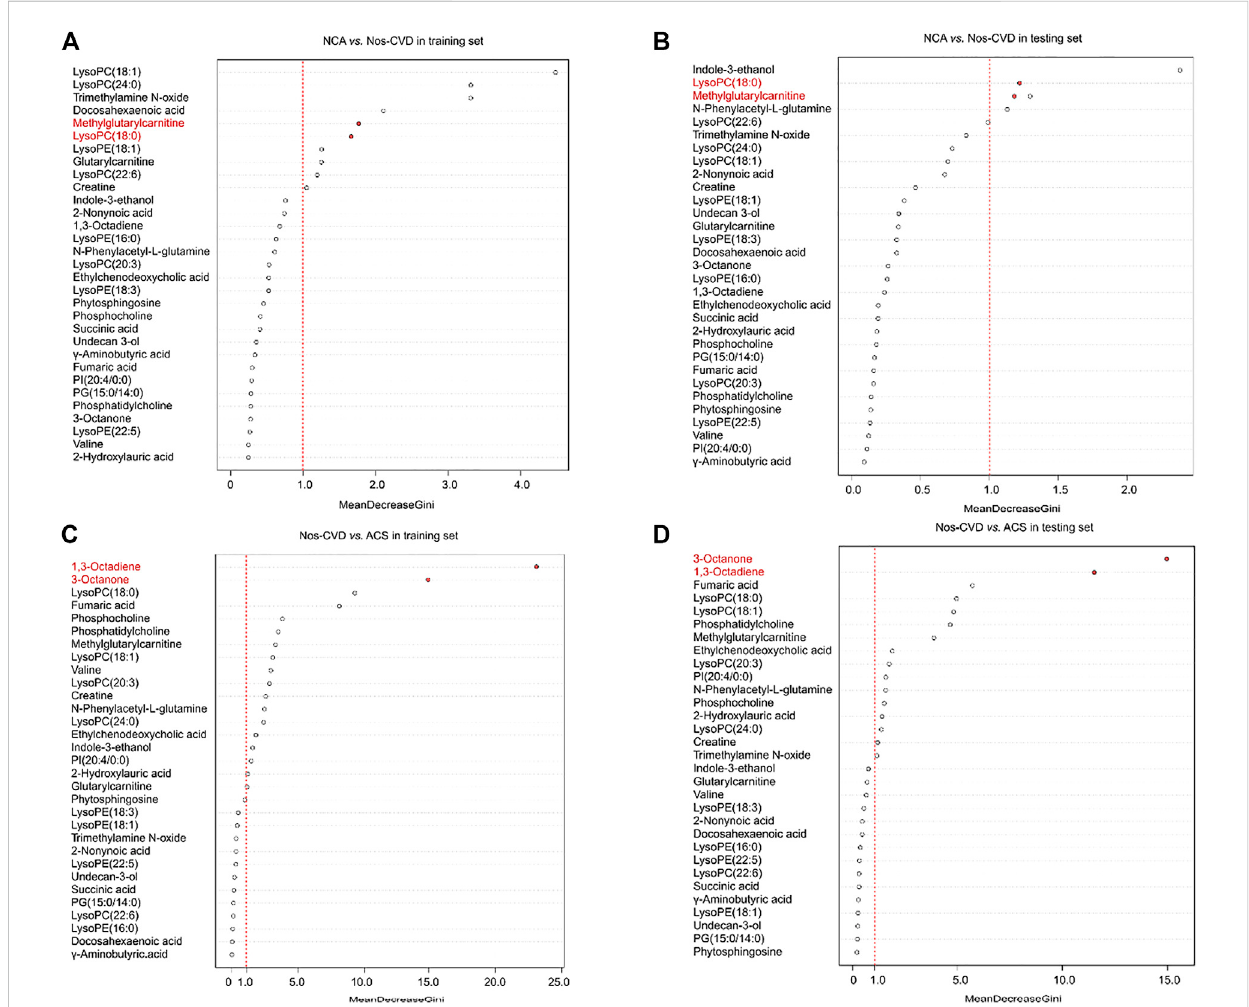
FIGURE 2 The variable importance measure (VIM) of 34 metabolites by random forest for normal coronary artery (NCA) versus non-signi fi cant cardiovascular disease (nos-CVD) in training set (A) and in test set (B) , and for nos-CVDs versus acute coronary syndrome (ACS) in training set (C) and in test set (D) . The metabolites were ranked based on a decreasing order in mean decrease gini